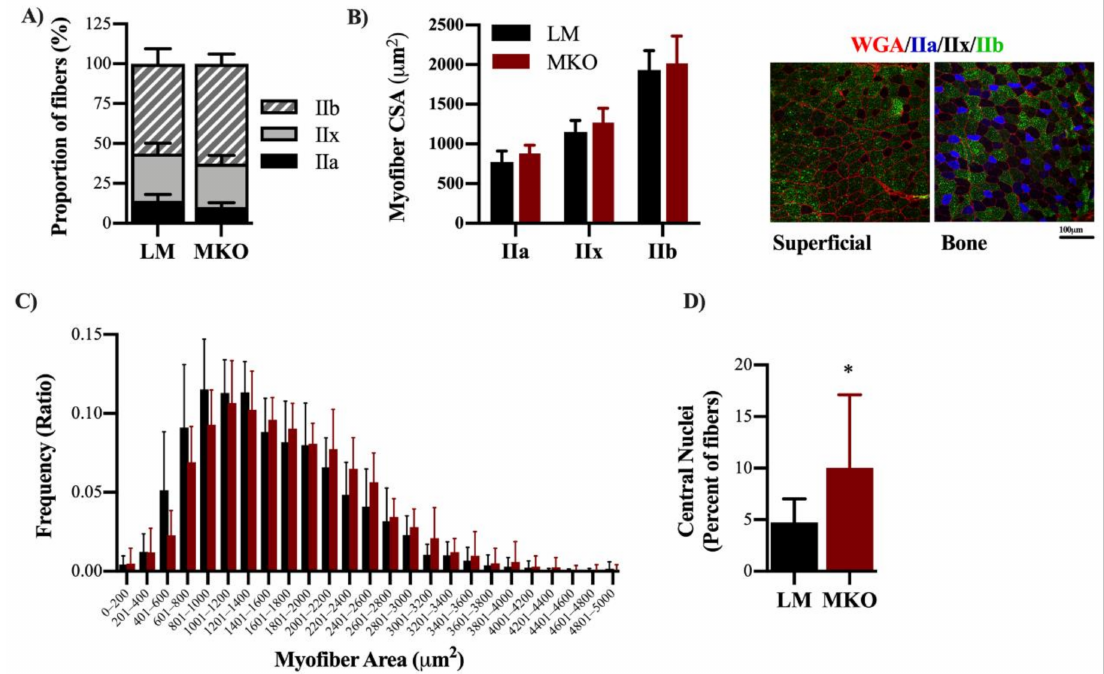
Figure 3. Ulk1 deficiency throughout life leads to altered muscle fibers anatomy. ( A ) Distribution of fiber types within TA muscle sections analyzed and representative images of fiber type staining. ( B ) CSA of different fiber types and representative images of fiber type staining. ( C ) Frequency distributions of fiber CSAs from TA muscles. ( p = 0.0035) ( D ) Percent of centrally located nuclei ( p = 0.0487) All data are presented as mean ± SD. * = significantly different from